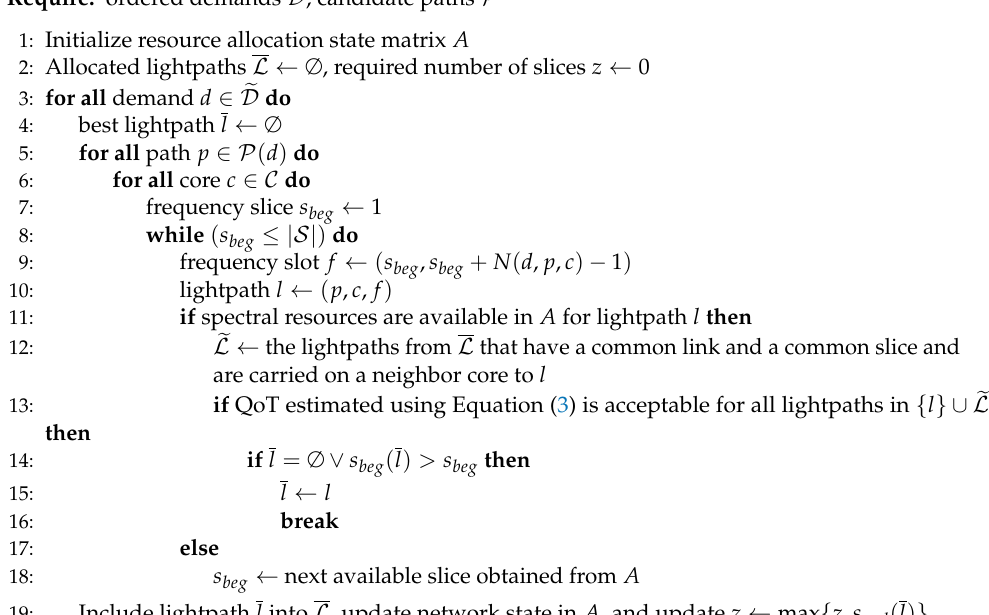
Algorithm 1 OSNR-Aware Lightpath Allocation (OSNR-LA)